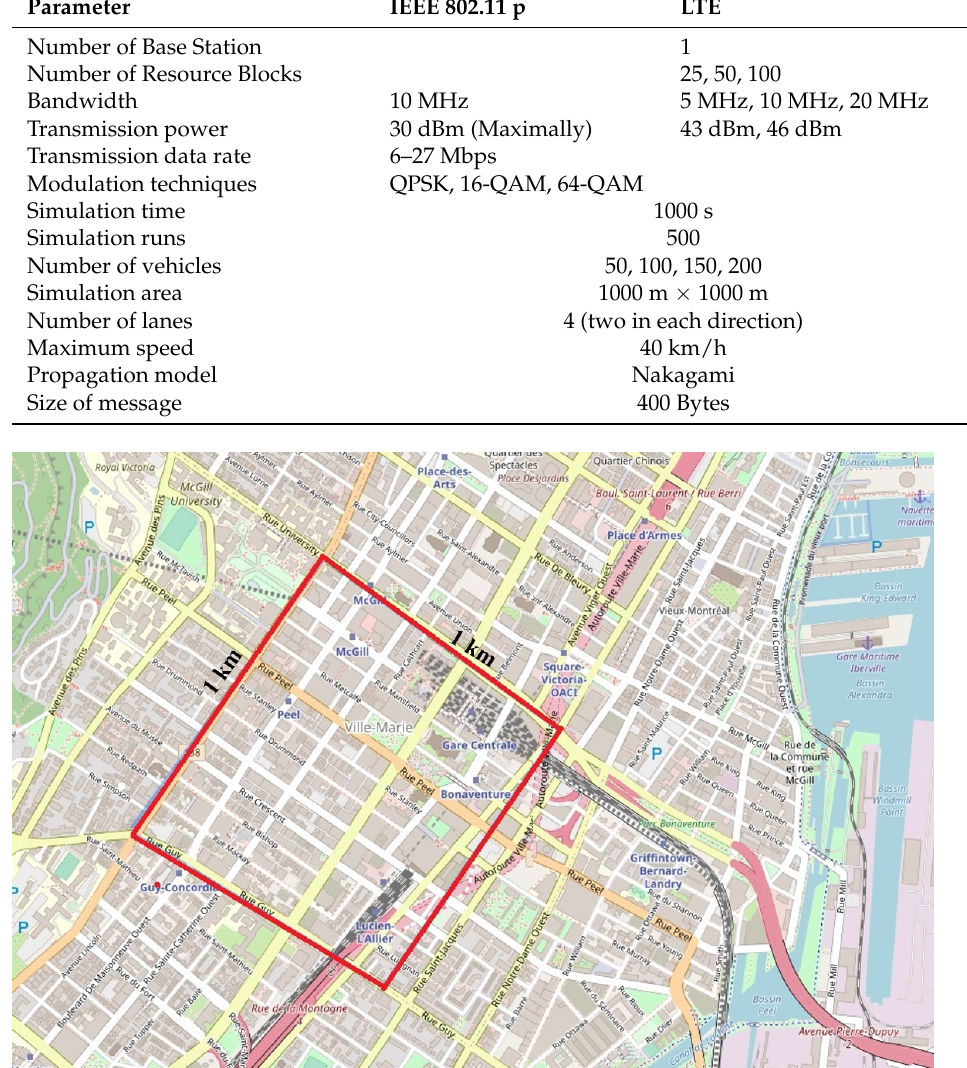
Figure 1. Simulated area is shown by a red